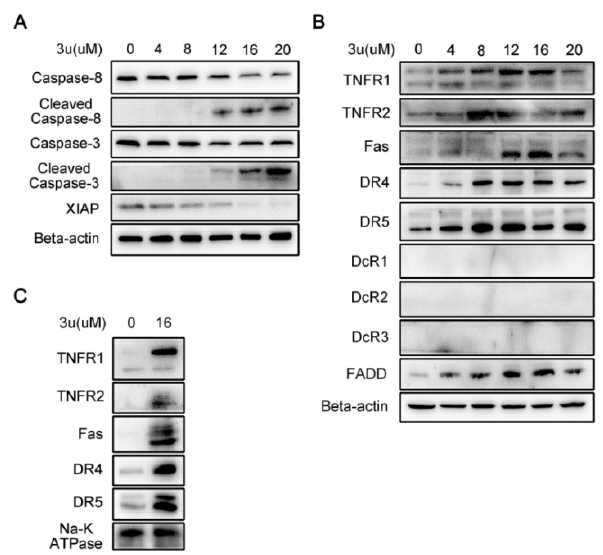
Figure 4. 3u-induced apoptosis was caused by upregulation of DRs and FADD via the extrinsic pathway. After 6 h of treatment of 3u in A375 cells ( A ) the extrinsic-related proteins were determined by Western blot analysis; ( B ) DRs and scaffold protein FADD, which initiated the death signal, were examined via immunoblot; and ( C ) membrane proteins were extracted, and DRs were determined by a western blot analysis.